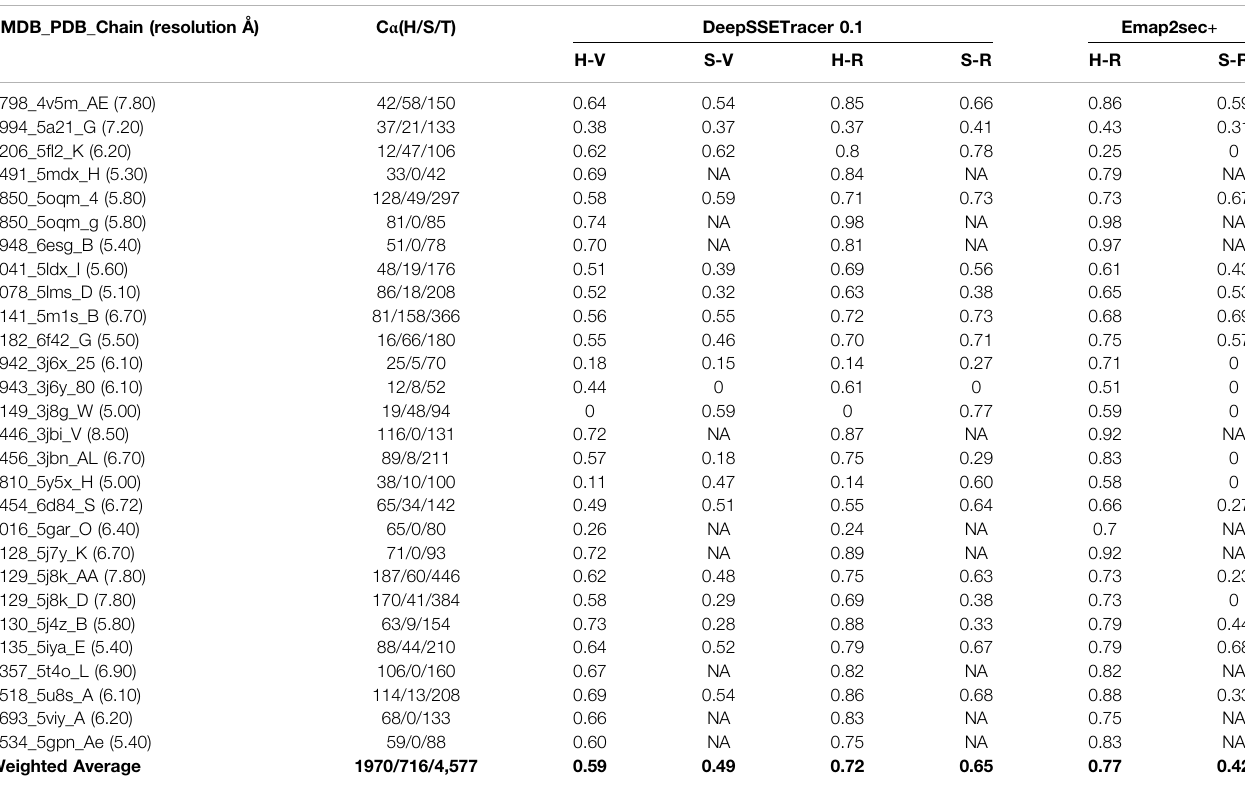
TABLE 2 | Evaluation of detected helices and β -sheets from DeepSSETracer 0.1 and Emap2sec+ using 28 cryo-EM component maps. From the left to right: the EMDB ID, PDB ID,chainIDwith theresolution ofthecryo-EM map inparentheses,thenumber ofC α atoms inthe STRIDE-annotated PDB fi le forH: helix,S: β -sheet, T:total ofthe chain, voxel-level of F1-scores for helix detection (H-V) and β -sheet detection (S-V), residue-level F1-scores for helix detection (H-R) and β -sheet detection (S-R) for DeepSSETracer 0.1 and Emap2sec+ respectively. NA: zero number of residues of the corresponding class in the atomic structure and unde fi ned precision or recall. EMDB_PDB_Chain (resolution Å) C α